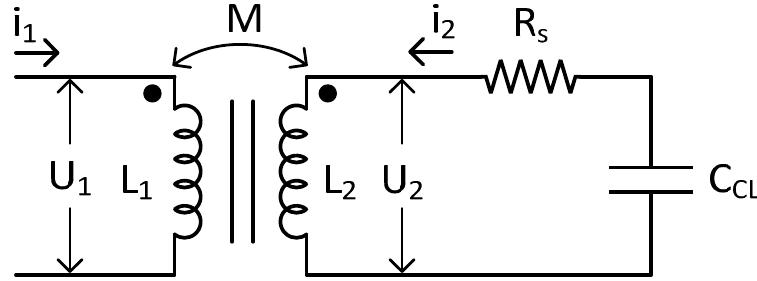
Figure 6. Electric model of the wireless temperature sensor considering a real transformer.